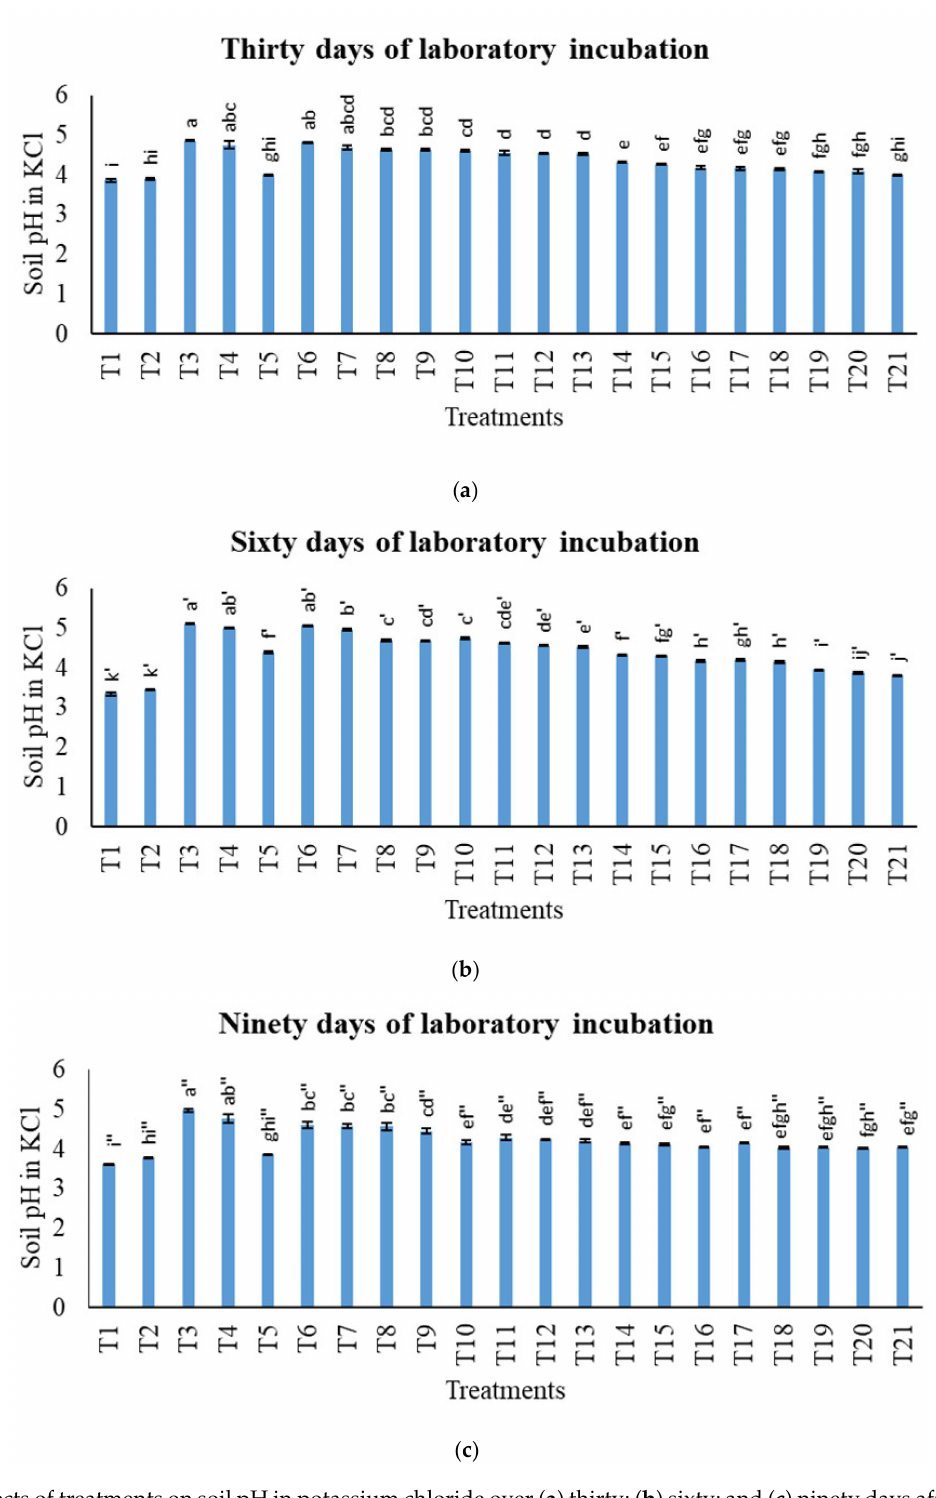
Figure 1. Effects of treatments on soil pH in potassium chloride over ( a ) thirty; ( b ) sixty; and ( c ) ninety days after incubation. T1: soil control, T2: conventional practice, T3: muriate of potash + 100% charcoal + 100% sago bark ash, T4: muriate of potash + 100% sago bark ash, T5: muriate of potash + 100% charcoal, T6: muriate of potash + 80% charcoal + 80% sago bark ash, T7: muriate of potash + 60% charcoal + 80% sago bark ash, T8: muriate of potash + 40% + 80% sago bark ash, T9: muriate of potash + 20% charcoal + 80% sago bark ash, T10: muriate of potash + 80 charcoal + 60% sago bark ash, T11: muriate of potash + 60% charcoal + 60% sago bark ash, T12: muriate of potash + 40% charcoal + 60% sago bark ash, T13: muriate of potash + 20% charcoal + 60% sago bark ash, T14: muriate of potash + 80% charcoal + 40% sago bark ash,